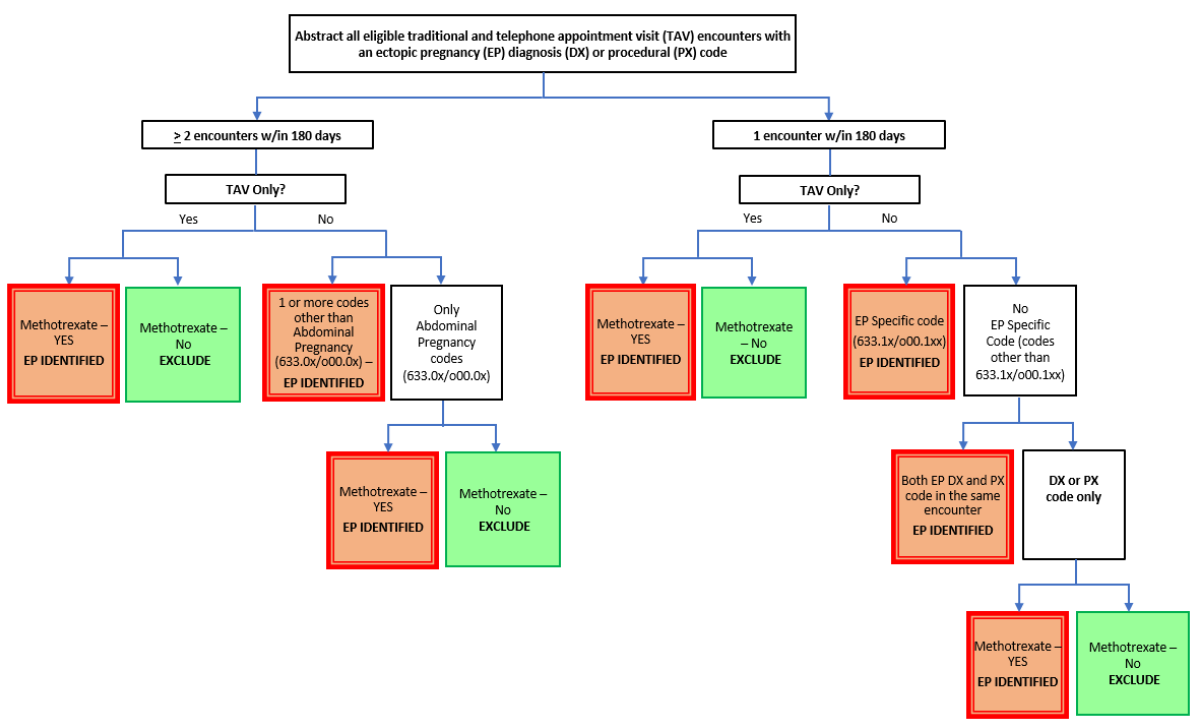
Figure 1. Enhanced ectopic pregnancy